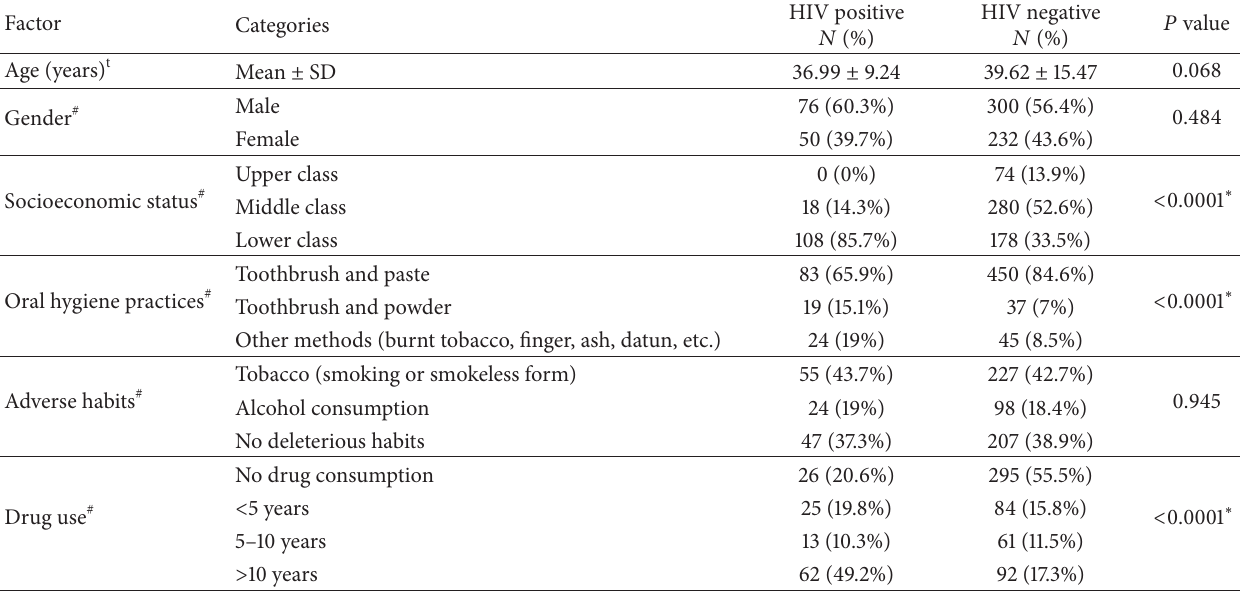
Table 1: Sociodemographic data, oral hygiene practices, and adverse habits of HIV positive and negative individuals.